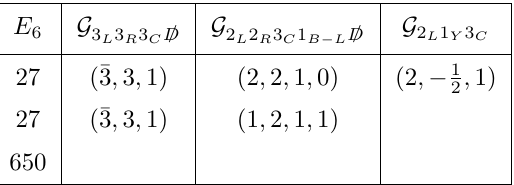
Table 3. Higgs representations that contribute to the RGEs at each stage of the symmetry breaking for the E model in section 6